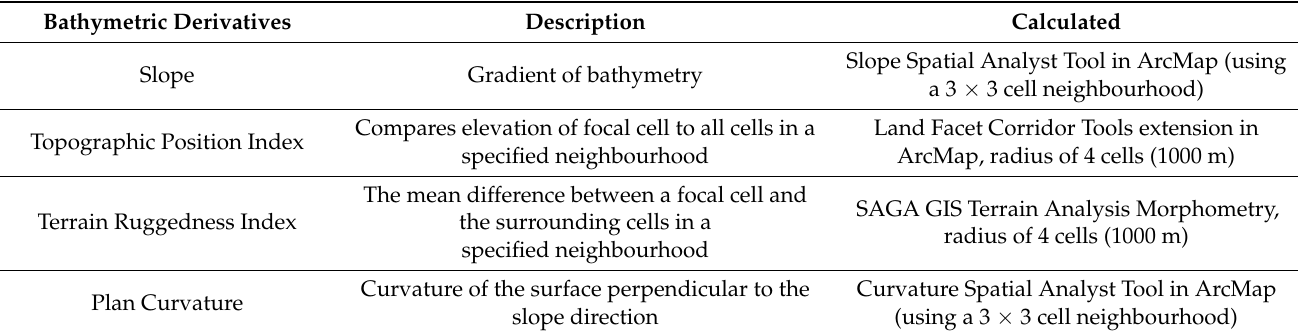
Table 1. Bathymetric derived variables included in the landscape mapping analysis.